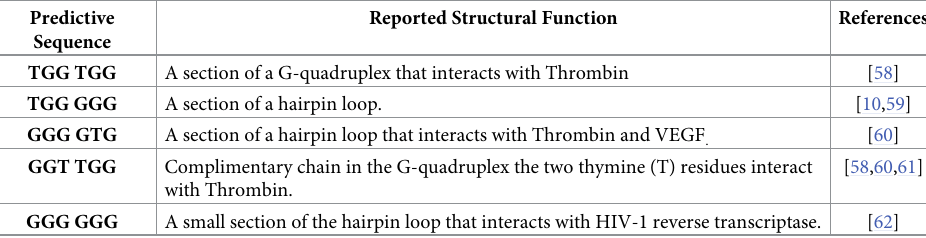
Reported Structural Function